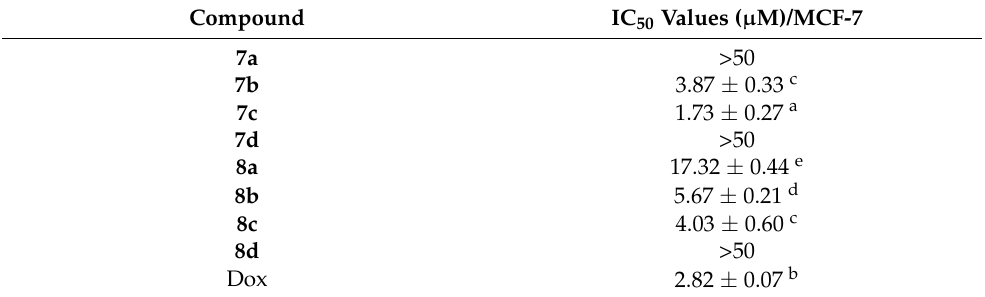
Table 1. In vitro anticancer activity of quinolinone derivatives 7a – d and 8a – d against MCF-7 cell